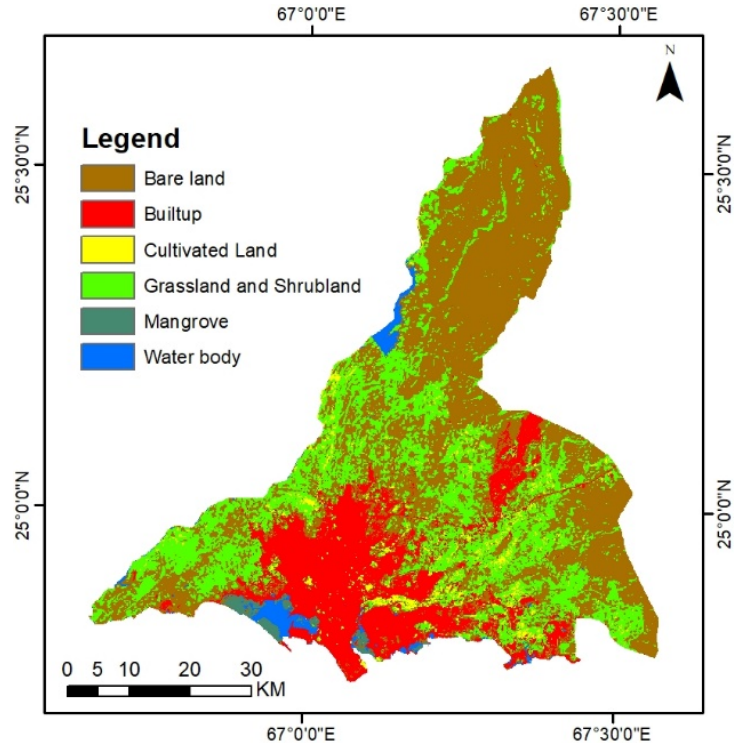
Figure 8. LULC prediction results for Karachi city in 2030.